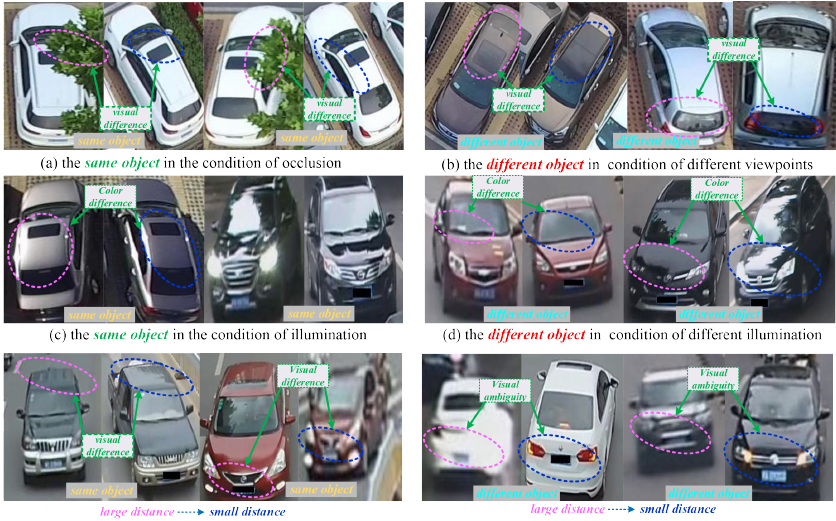
Figure 1. Illustration of parts of the challenges faced by UAV-based object Re-ID platform: ( a ) object appearance ambiguity by occlusions; ( b ) viewpoint variance resulted in dramatically different appearances of the same object; ( c ) illumination variance led to appearance ambiguity of the same objects; ( d ) illumination variances led to appearance ambiguity of the different objects; ( e ) resolution variances led to a visual difference of the same objects in different distances; ( f ) resolution variances led to the visual difference of the different objects in different